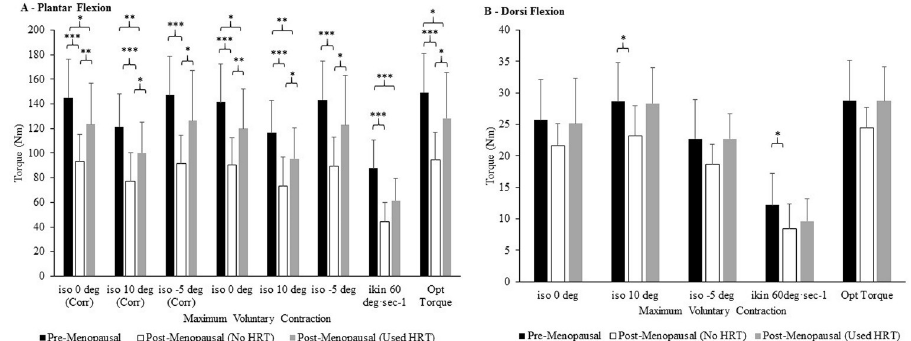
Fig 1. Comparison of participants’ plantar flexion (A) and dorsi flexion (B) maximum voluntary contraction at various isometric ankle angles (0, 10–5 degrees) and one isokinetic speed (60 deg � sec -1 ) categorized by participants’ menopause phase and use of hormone replacement therapy. Values are means ± SDs. Different from Pre-Menopausal and Post-Menopausal, � P < 0.05, �� P < 0.01, ��� P < 0.001. Abbreviations: Corr, is MVC Corrected for co- contraction. Also referred to Net MVC in the text; Deg, Degree; ikin, isokinetic; iso,